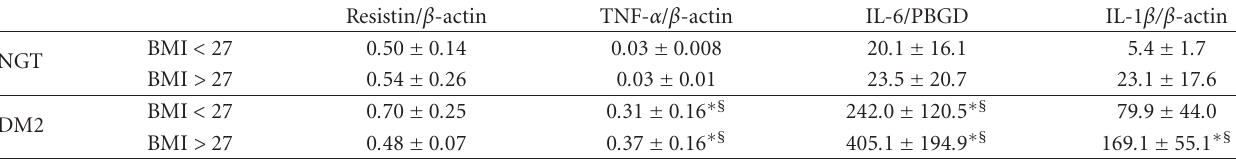
Figure 1: (a) Bar graphs compare relative resistin/ β -actin mRNA levels, (b) TNF- α / β -actin mRNA levels, (c) IL-6/PBGD mRNA levels, and (d) IL-1 β / β -actin mRNA levels, from peripheral mononuclear-enriched monocytes from NGT-control and DM2 women. ∗ P < . 05 versus NGT-women. Table 3: Relative resistin, TNF- α , IL-6, and IL-1 β mRNA levels from mononuclear cells between the subgroups of the NGT- and the DM2-